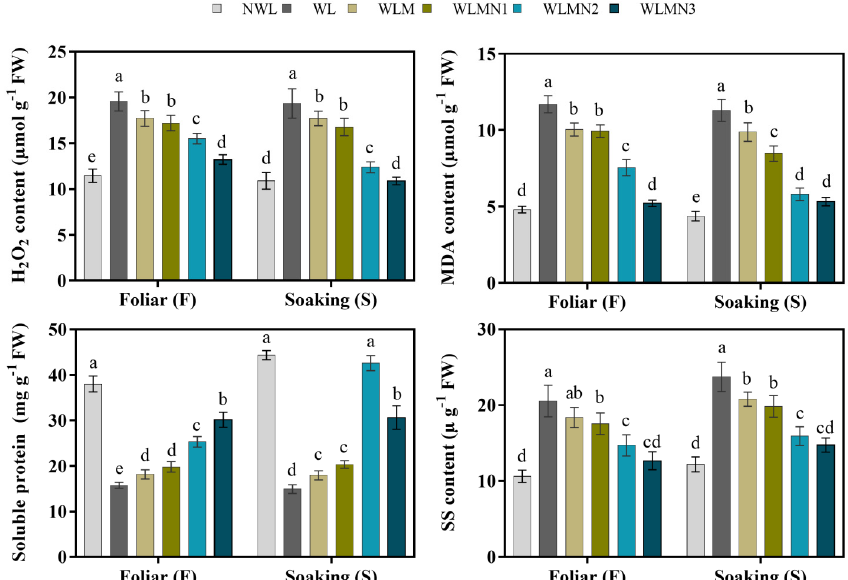
Figure 4. H 2 O 2 , MDA, soluble and soluble sugar content of maize seedlings under waterlogging stress conditions. Data are presented as mean ± SD ( n = 3, biological replicates). Different small let- ters (a,b,c,d,e) in each column indicate significant differences at p ≤ 0.05 (least significant difference (LSD) test). The abbreviations of treatment names are the same as those described in Table 2. Waterlogging (WL) significantly decreased the soluble protein content of maize seed- lings compared with NWL, WLM and treated plants (Figure 4). Our results showed that melatonin with KNO 3 increased the soluble protein content at various degrees than WLM. The results demonstrated that soluble protein was significantly increased in treatments WLMN1, WLMN2 and WLMN3 by 26.01%, 61.16%, and 91.90% under the foliar spray, while in seed soaking, the maximum soluble protein content obtained was in the WLMN2